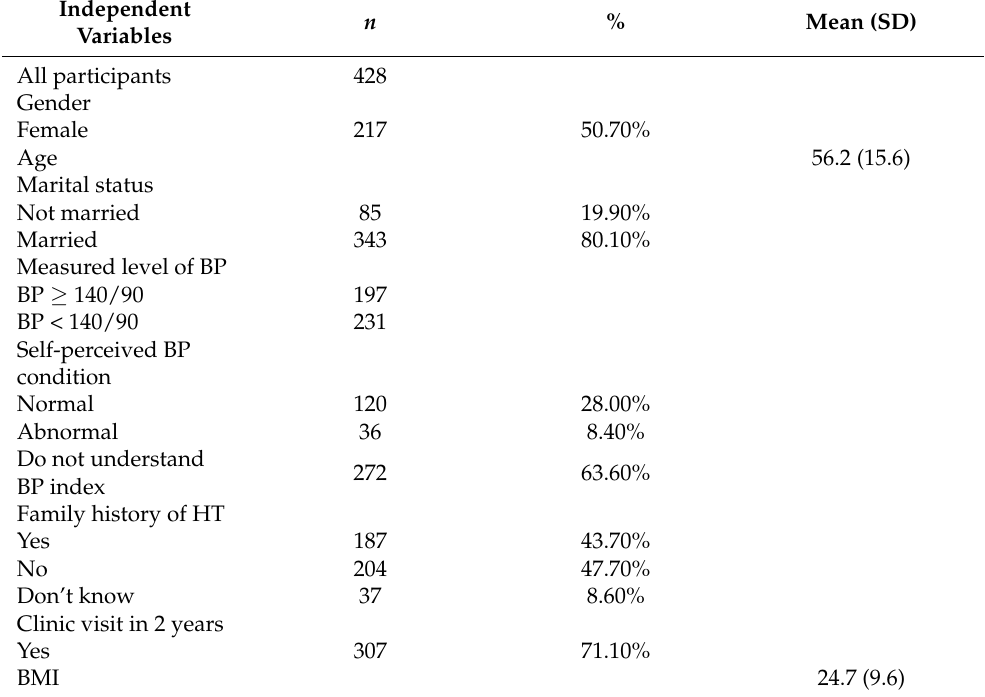
Table 1. Participants